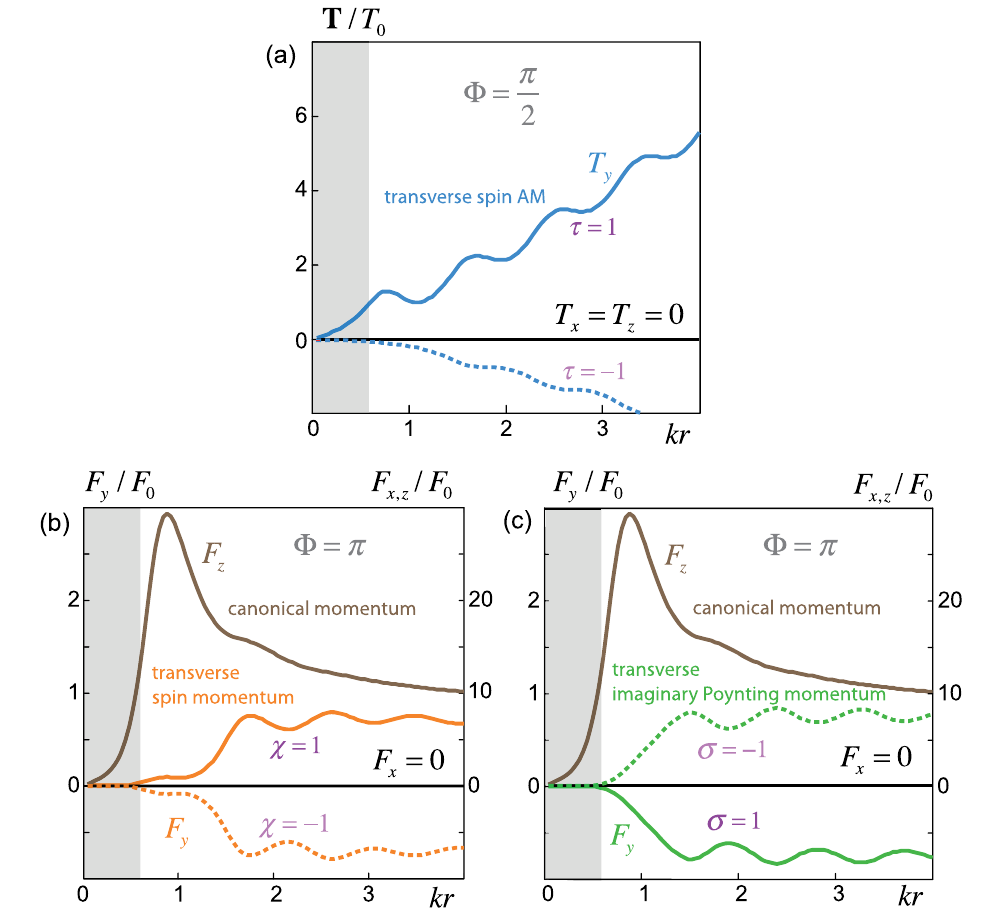
FIG. 4. Optical forces and torques on a gold Mie particle in the two-wave interference field. Exact numerical calculations of the forces and torques exerted by the two-wave interference field [Eq. (2)] with γ ¼ 0 . 1 and different polarizations on a gold Mie particle suspended in water (see the Appendix). The forces and torques (normalized by the factors F 0 ¼ gr 2 A 2 and T 0 ¼ F 0 =k ) are plotted as functions of the dimensionless radius of the particle, kr . The light gray areas schematically indicate the Rayleigh dipole-approximation range kr ≪ 1 . (a) Optical torques for the simplest case of linear polarizations m ¼ 0 and m ¼ ∞ , i.e., the Stokes parameters τ ¼ (cid:2) 1 , and particle ’ s x position corresponding to Φ ¼ π = 2 . The strong transverse torque clearly indicates the presence of a transverse helicity- ∝ S e S independent spin AM: T for the in-plane polarization τ ¼ 1 ; see Eqs. (11) and (15) and Fig. 2. The same torque becomes y y y ¼ S m weak and negative for the τ ¼ − 1 polarization, because in this case the transverse spin has magnetic origin, S , and it is weakly y y ¼ coupled to the nonmagnetic gold particle. (b),(c) Optical forces for the diagonal and circular wave polarizations m ¼ (cid:2) 1 and m ¼ (cid:2) i , i.e., the Stokes parameters χ ¼ (cid:2) 1 and σ ¼ (cid:2) 1 , and particle ’ s x position corresponding to Φ ¼ π . The strongest force is the longitudinal ∝ P e radiation-pressure force proportional to the z -directed canonical momentum of light, F , Eqs. (10) and (14). The gradient force is z z ∝ ∇ W e ¼ 0 . Importantly, a weak polarization- absent because the particle is located in the maximum of the electric-field intensity: F x x dependent transverse force F appears beyond the Rayleigh dipole approximation, i.e., at kr ∼ 1 . This force [Eq. (16)] indicates the y ∝ Re ð Π P presence of the transverse χ -dependent Belinfante spin momentum δ F and σ -dependent imaginary Poynting y y Þ ¼ Sy ∝ Im ð Π momentum δ F , Eqs. (12) and (13) and Fig. y y Þ